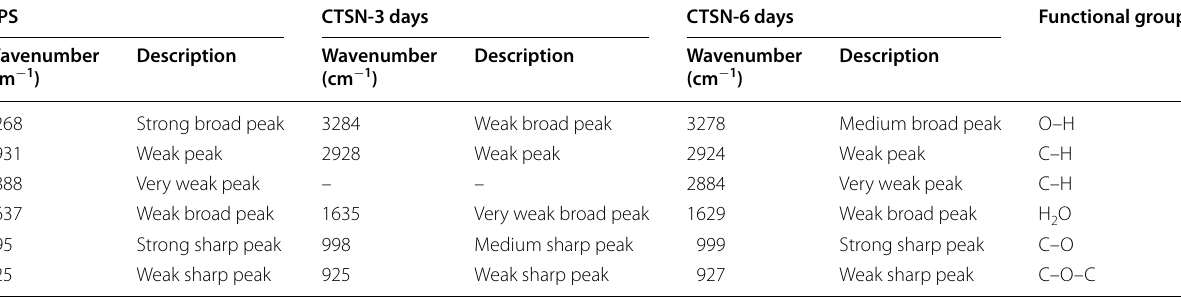
Table 5 Table of untreated potato starch (UPS) and chemically treated starch nanoparticles (CTSN) wavenumbers depicted in FTIR analysis with corresponding functional groups